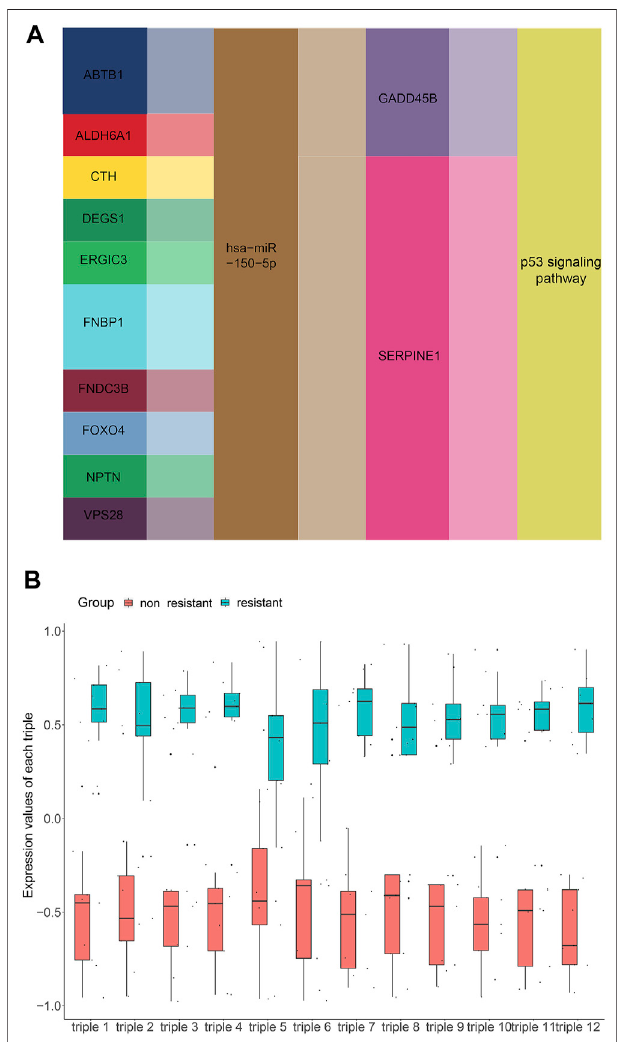
FIGURE 6 | Screening for core lncRNA-miRNA-mRNA networks. (A) Identi fi cation of core lncRNA-miRNA-mRNA networks, based on the criteria R > 0.85 and p < 0.01. (B) Expression of core lncRNA-miRNA-mRNA networks in non-resistant group and EGFR-TKIs resistant group.